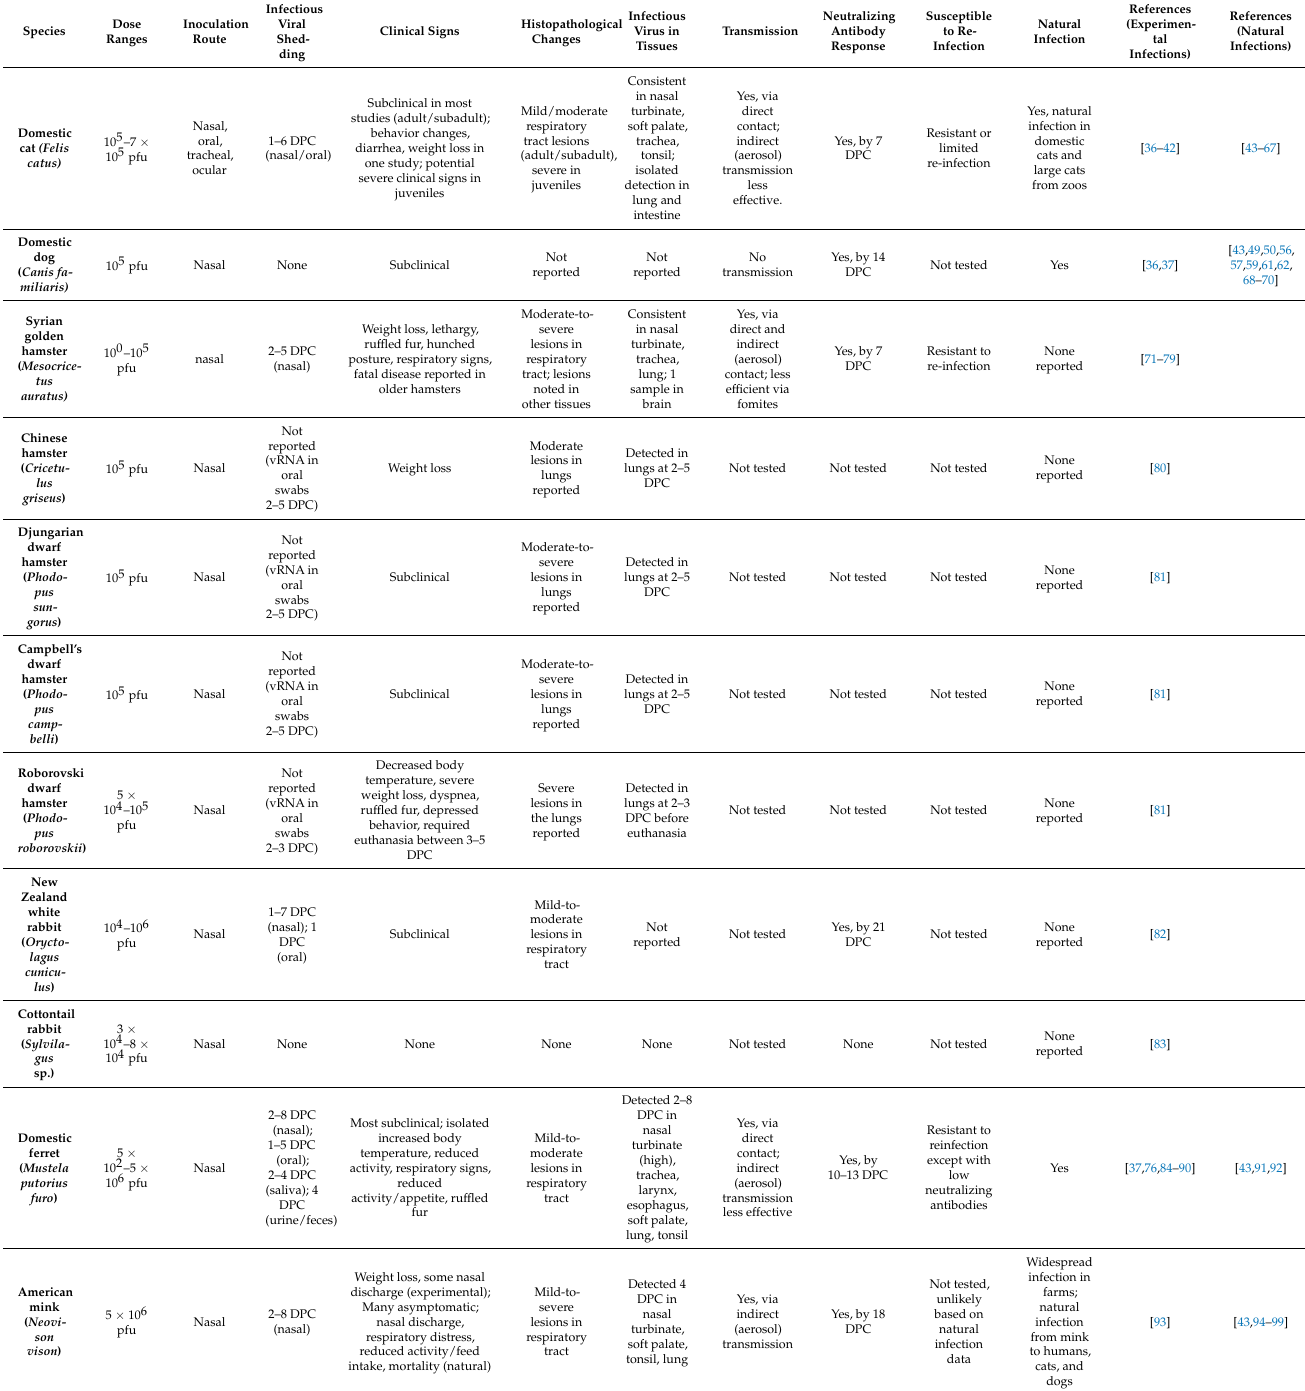
interface. A table outlining the disease manifestations of SARS-CoV-2 infection in different domestic and wild species (Table 1) and a figure outlining natural human-to-animal infec- tions, susceptibility/disease severity of different animal species, threats to public health among animal species, and suitability of different susceptible species as pre-clinical models (Figure 1) are included. Table 1. Outline of SARS-CoV-2 susceptibility and disease course in different animal